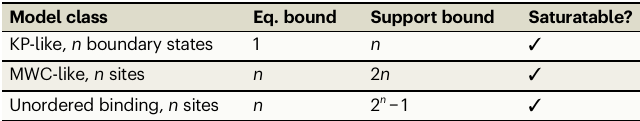
Table 1 | Support bound compared to the bounds on sensi- tivity that hold at thermodynamic equilibrium (Eq.), for three classes of models we have